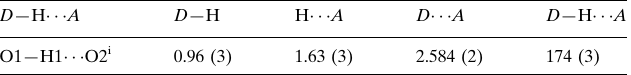
Hydrogen-bond geometry (A˚ , (cid:4)